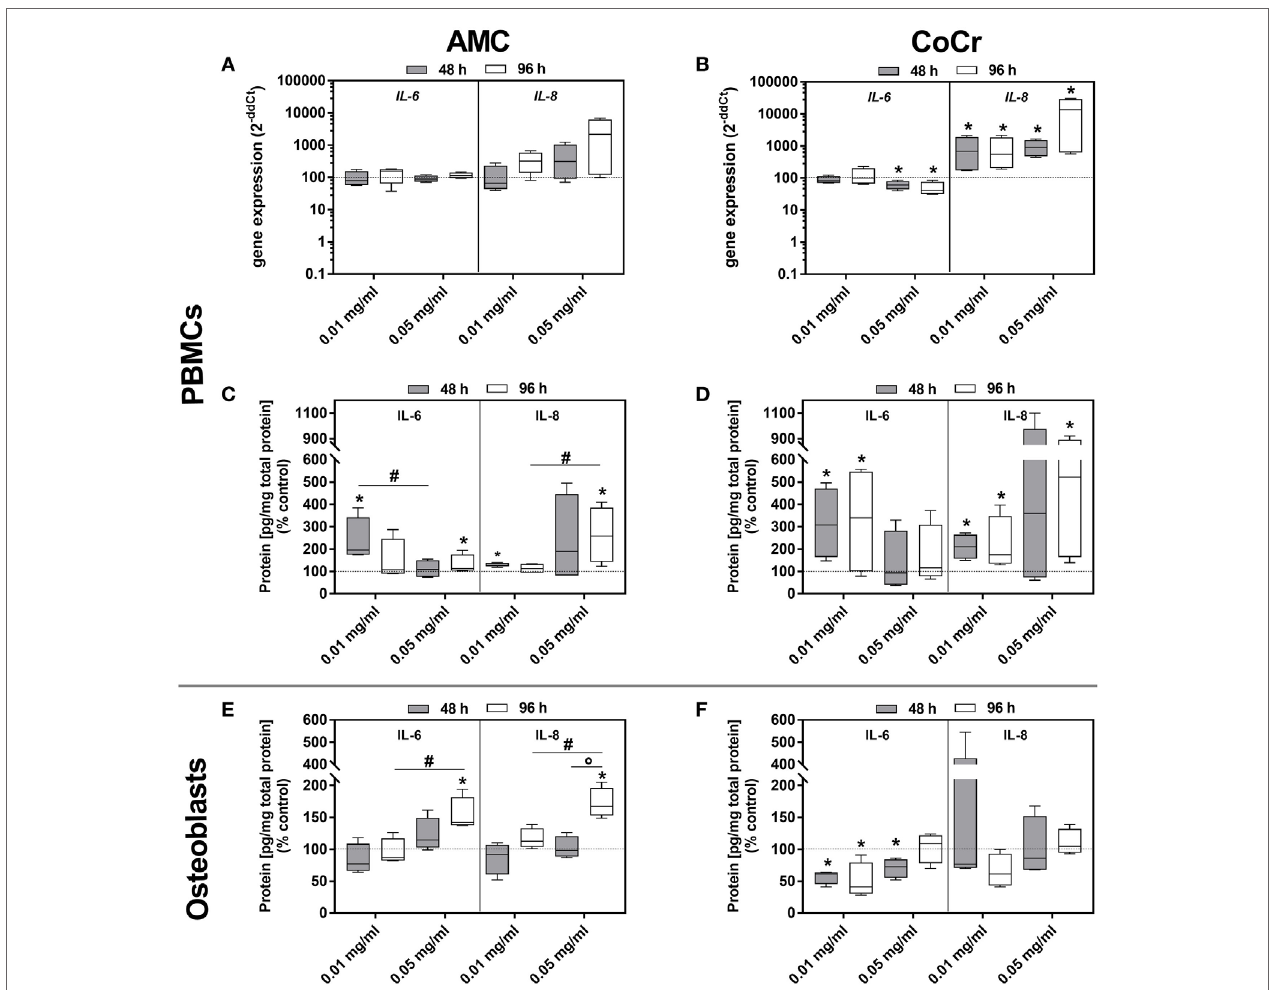
FigUre 7 | IL-6 and IL-8 expression rates in human PBMC cultures and osteoblasts following exposure to AMC and CoCr particles. PBMCs were treated with the respective particle to evaluate gene expression levels of IL-6 and IL-8 by qRT-PCR (a,B) . (c–F) Cell culture supernatants of particle-exposed PBMCs and osteoblasts were used to evaluate the concentration of soluble IL-6 and IL-8 protein (per total protein content). Data are shown as median and minimum/maximum values ( n = 4). Significances between groups were calculated with the Mann–Whitney U -test (* p < 0.05, treated vs. untreated; # p < 0.05, 0.01 vs. 0.05 mg/ml).